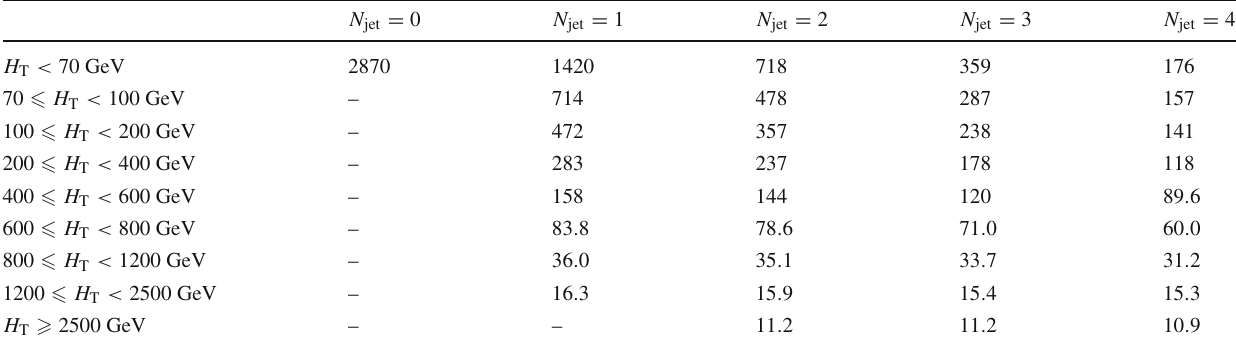
Table 8 Stitching weights s i for the case that the inclusive and exclu- sive W+jets samples given in Tables 1 and 4 are stitched based on the observables N jet and H T . The weights are computed for an integrated luminosity of 140 fb − 1 . Events with N jet = 0 all have H T < 70 GeV, and, similarly, events with N jet = 1 all have H T < 2500 GeV. Hence,